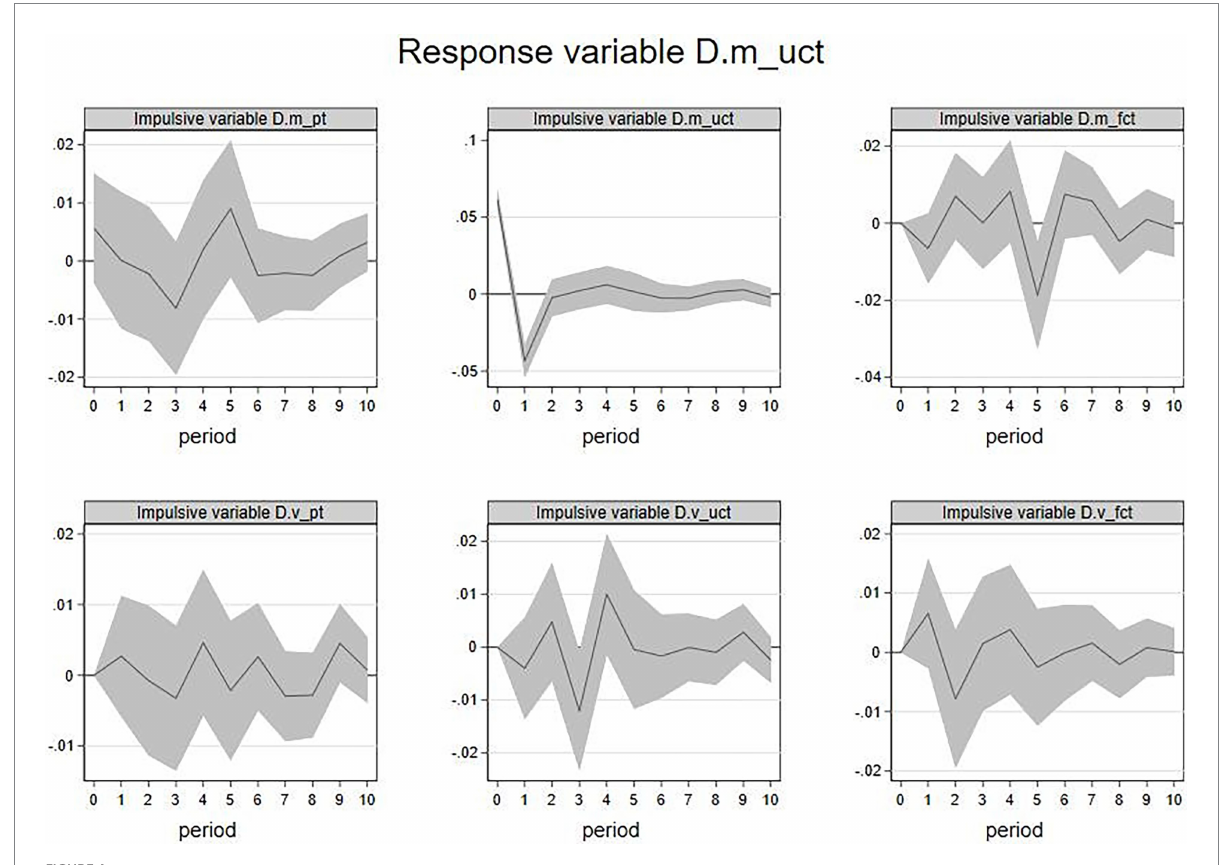
FIGURE 4 IRF: _ D.m uct (response